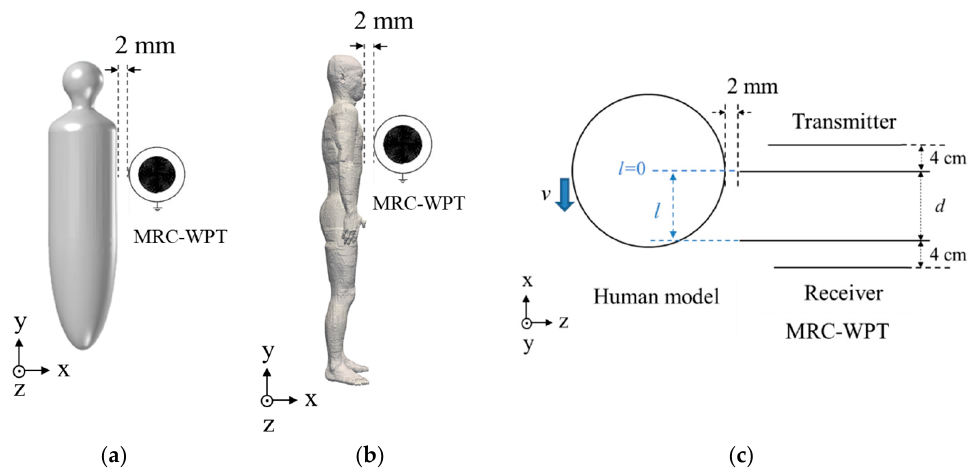
Figure 4. The MRC-WPT with respect to the ( a ) homogeneous body and ( b ) TARO models. ( c ) Top view of the MRC-WPT and homogenous human model.